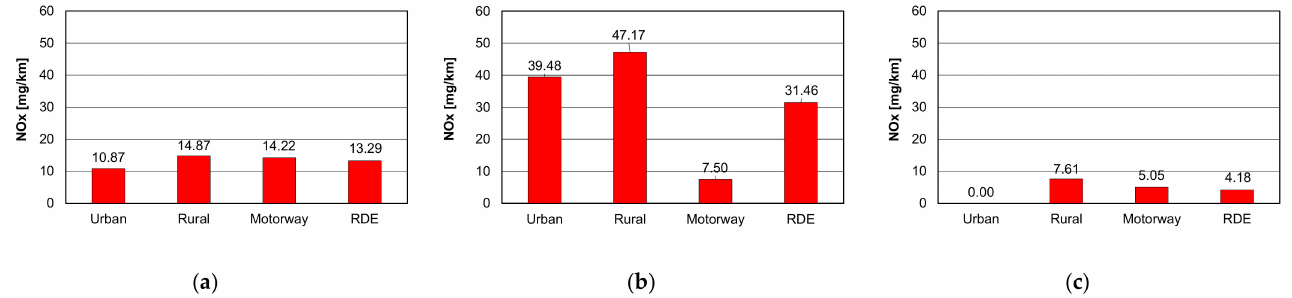
Figure 10. Results of tests of nitrogen oxides on-road emission in a passenger vehicle with a gasoline engine ( a ), a diesel engine ( b ), PHEV ( c ).